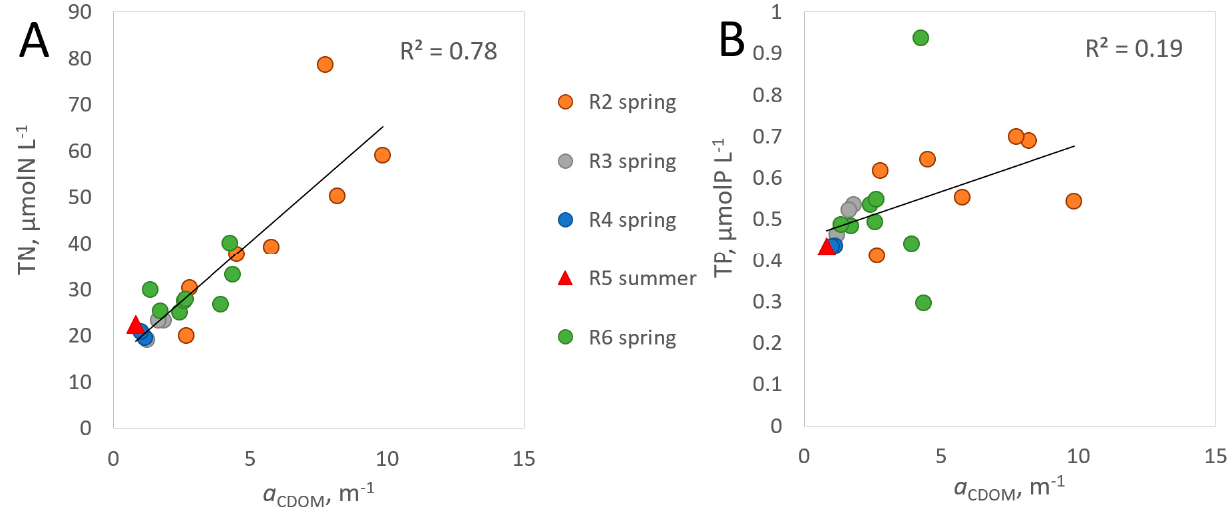
Figure 3. Correlation and the linear regression line (black) between in situ absorption of coloured organic dissolved matter at 400 nm ( a CDOM ) and ( A ) in situ total nitrogen (TN), and ( B ) in situ total phosphorus (TP) of the match-up dataset.